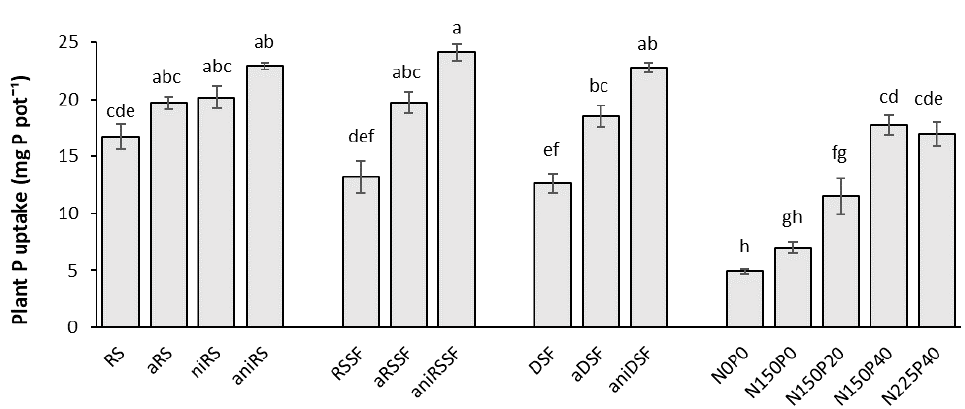
Figure 6. Total P uptake for untreated and acidified organic products and reference mineral fertilizers 35 DAS as mean values of 4 replicates. RS: Raw slurry; RSSF: Raw slurry solid fraction; DSF: Digestate solid fraction; a: Acidified; ni: Nitrification inhibitor; ani: acid+ni; NxPy: mineral N and P reference fertilizer at x mg N and y mg P kg − 1 soil. Error bars represent standard error of the mean ( n = 4). Treatments with different letters (across all levels) are significantly different ( P < 0.05) according to the Tukey test.